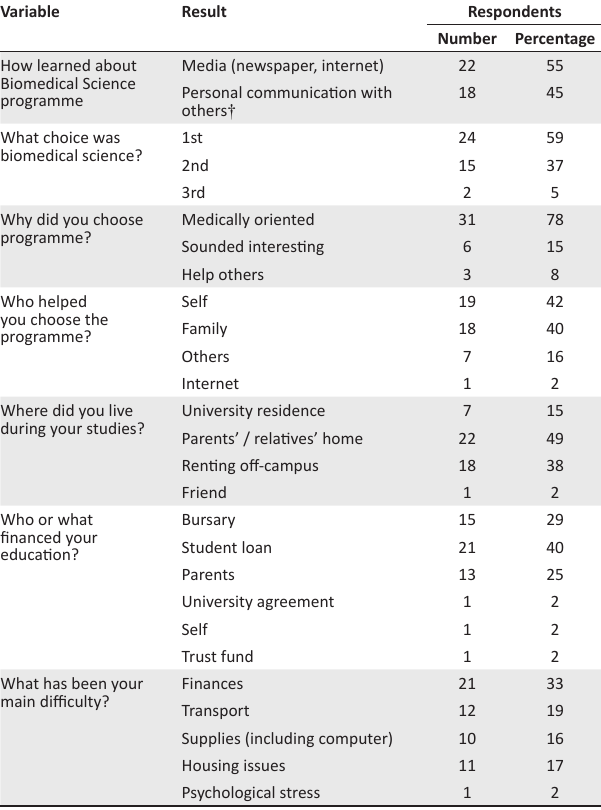
TABLE 2: Perceptions and experiences of fourth-year students in the Biomedical Science programme at the Polytechnic of Namibia in 2011 and 2012. Variable